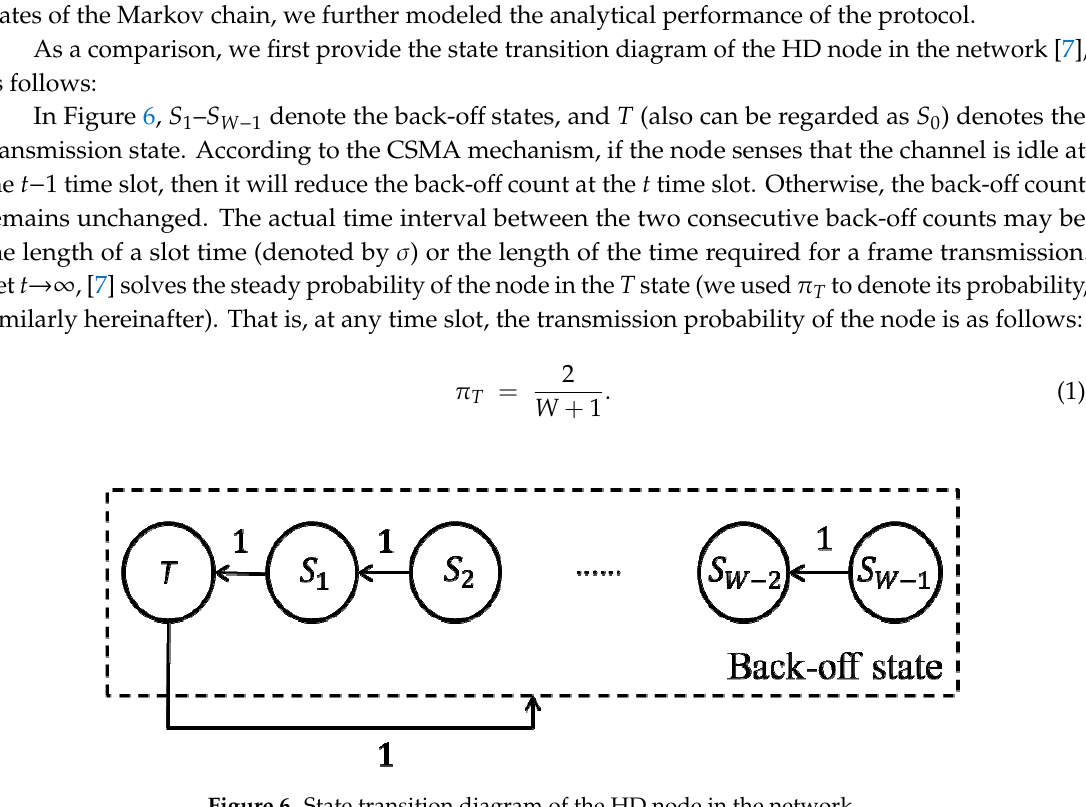
Figure 6. State transition diagram of the HD node in the network.